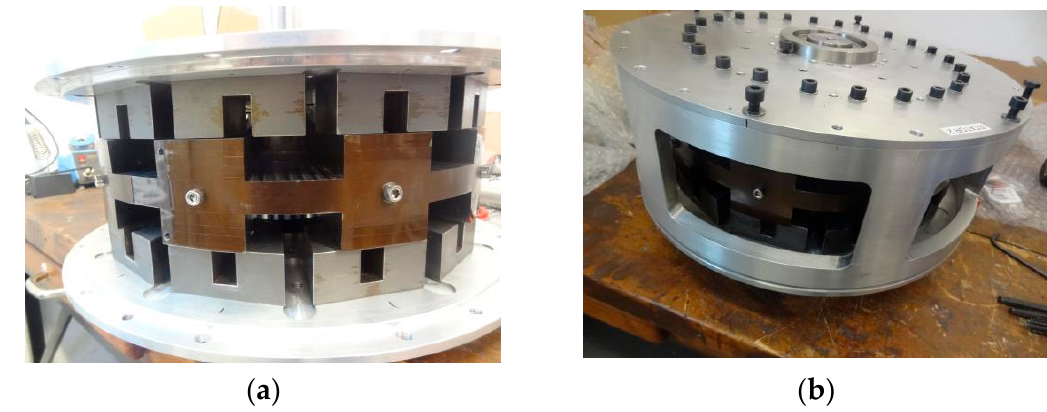
Figure 3. Prototype assembly: ( a ) before inserting the permanent magnets (PMs) and adding the outer carcass; ( b ) with the outer carcass installed.